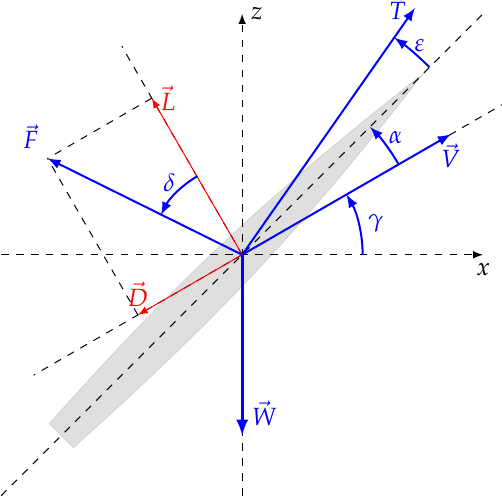
Figure 1. Forces on a rocket in flight. See text for the definition of the